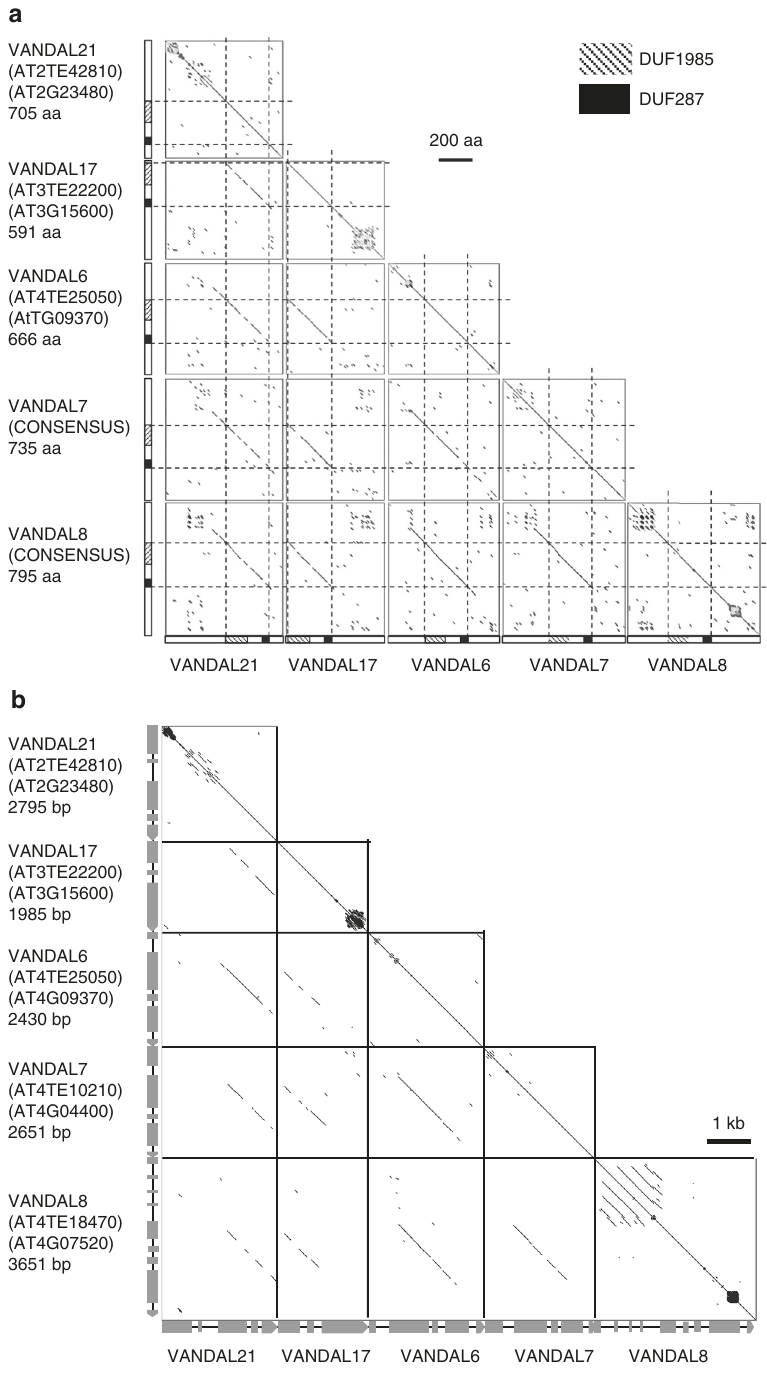
Fig. 5 Dot plot analyses of the VANC proteins. a Comparison of amino-acid sequences of the VANC proteins. Homologous regions were plotted with dotmatcher program (window size: 10, threshold: 23). Amino-acid sequences (N ʹ – C ʹ ) were ordered from top to bottom and left to right. Scale bar for 200 a.a. was shown in the right of plots. Two domains (DUF1985 and DUF287) are shown by shaded and fi lled areas, respectively. VANA (transposase), another protein encoded in these VANDAL members, is much more conserved (Supplementary Fig. 10). b Comparison of the nucleotide sequences of VANC genes. VANC genes were plotted with YASS program under default parameters 52 . DNA sequences are ordered from top to bottom and left to right. Gray boxes indicate exons. Divergence between these VANDAL families as well as divergence between the VANDAL copies in A. thaliana and A. lyrata is shown in Supplementary Tables 3, 4 and Supplementary Fig.